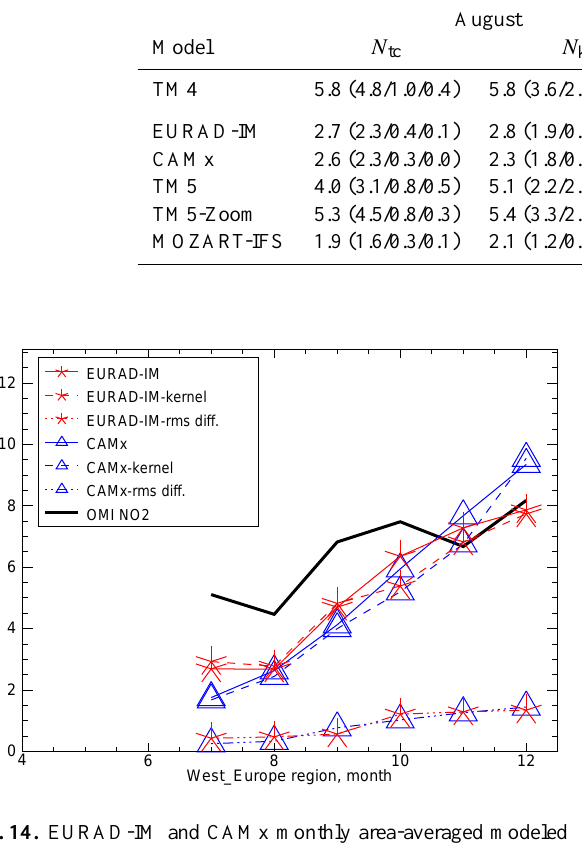
Fig. 14. EURAD-IM and CAMx monthly area-averaged modeled tropospheric NO 2 column ( N tc ) and the version using the averaging kernel ( N k ). Average over western Europe region. Also shown the OMI retrieval and the area-averaged RMS-differences between N tc and N k for both